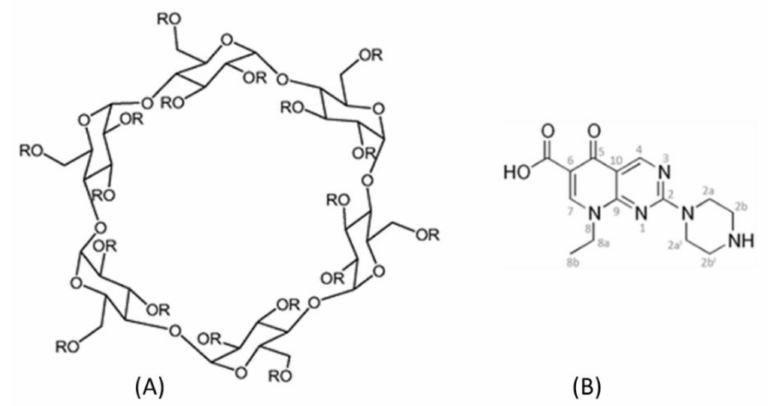
Figure 1. The molecular structure of Heptakis (2,3,6-tri- O -methyl)- β -cyclodextrin (TRIMEB), R = Me. ( A ) and pipemidic acid (HPPA) ( B